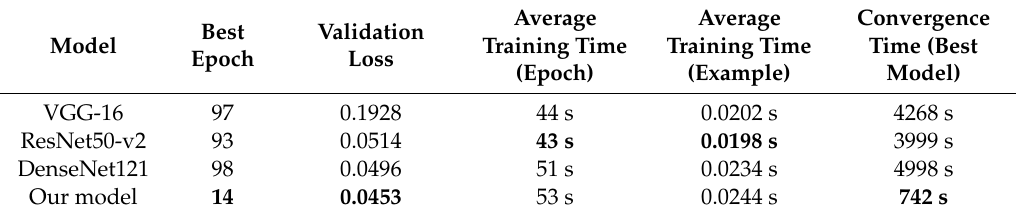
Table 3. Comparison of validation loss and training time for all models.